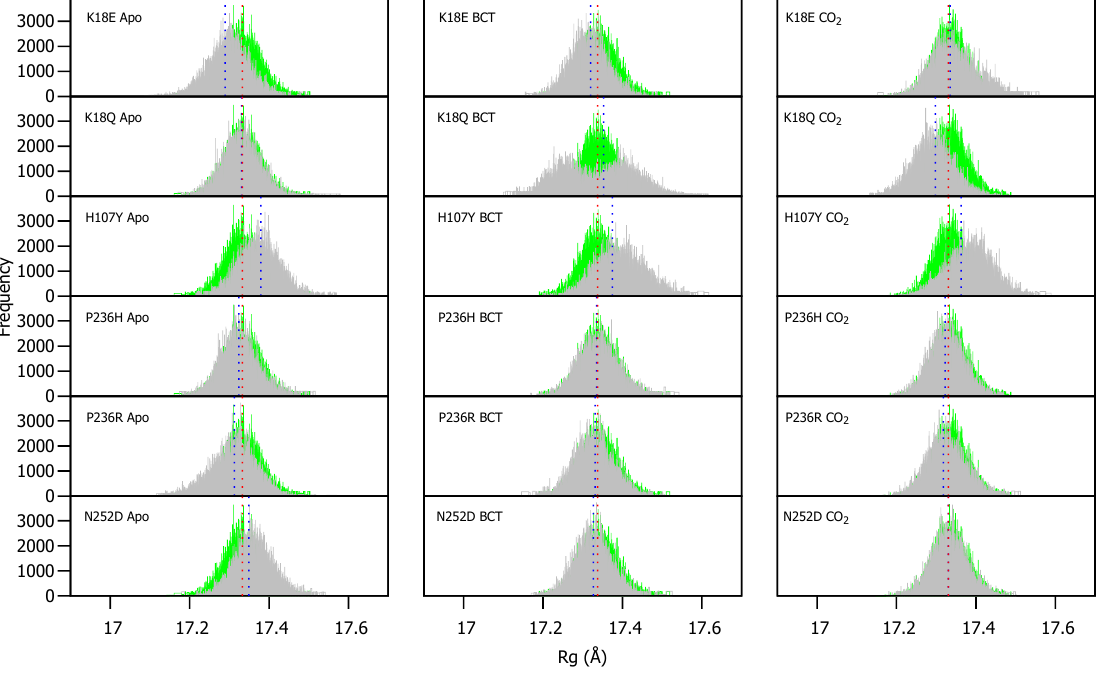
Figure 4. Rg distribution of the WT and variant proteins over the 200 ns MD simulation. The green and grey histograms indicate the Rg distribution of the WT and variant protein, respectively. The red and blue dashed lines represent the mean Rg of the WT and variant proteins, respectively. Variant apo, BCT and CO 2 proteins are each plotted against the WT apo, BCT and CO 2 bound proteins, respectively. The x-axis represents Rg of sampled conformations during MD simulation, whereas the y -axis (Frequency) represents number of times a specific conformation was